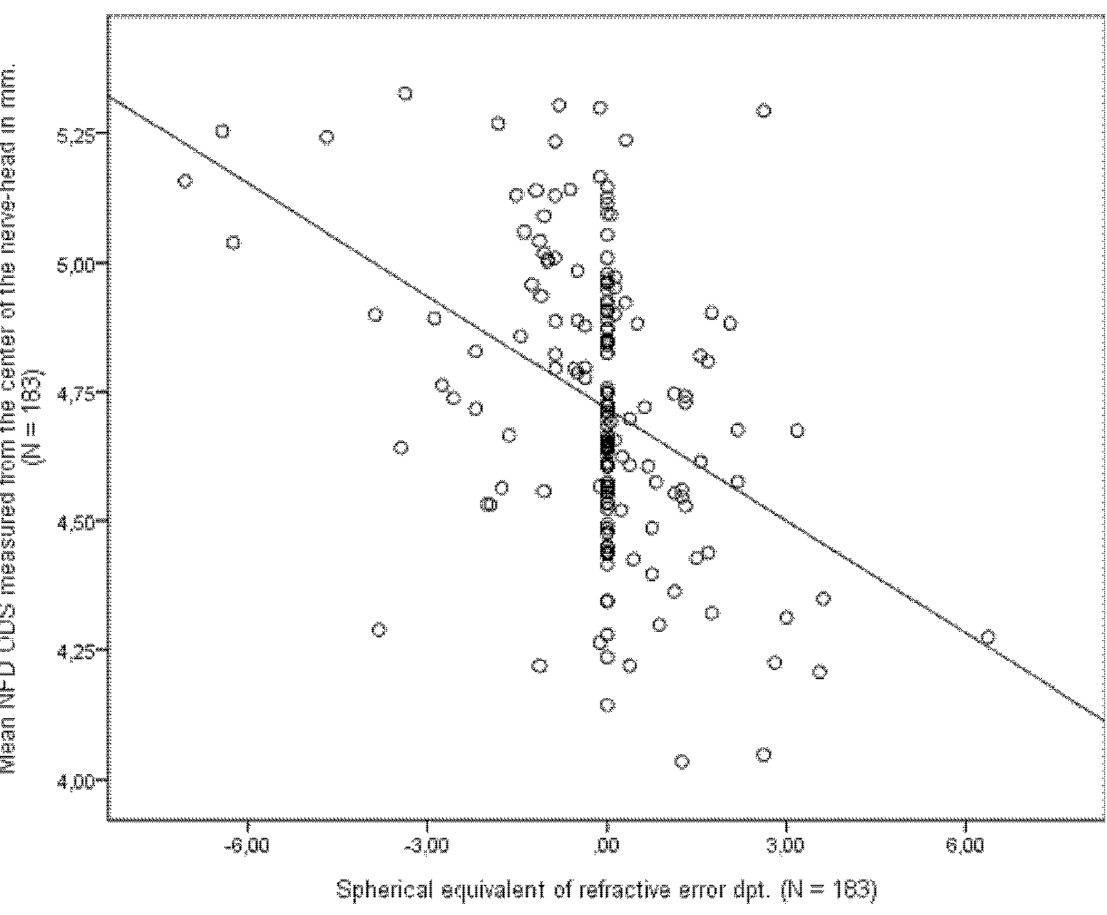
Figure 4. The spherical equivalent of the refractive error of 183 patients plotted against the mean NFD measured form the center of the nerve-head of both eyes (ODS) together with the line of equation (N=183).